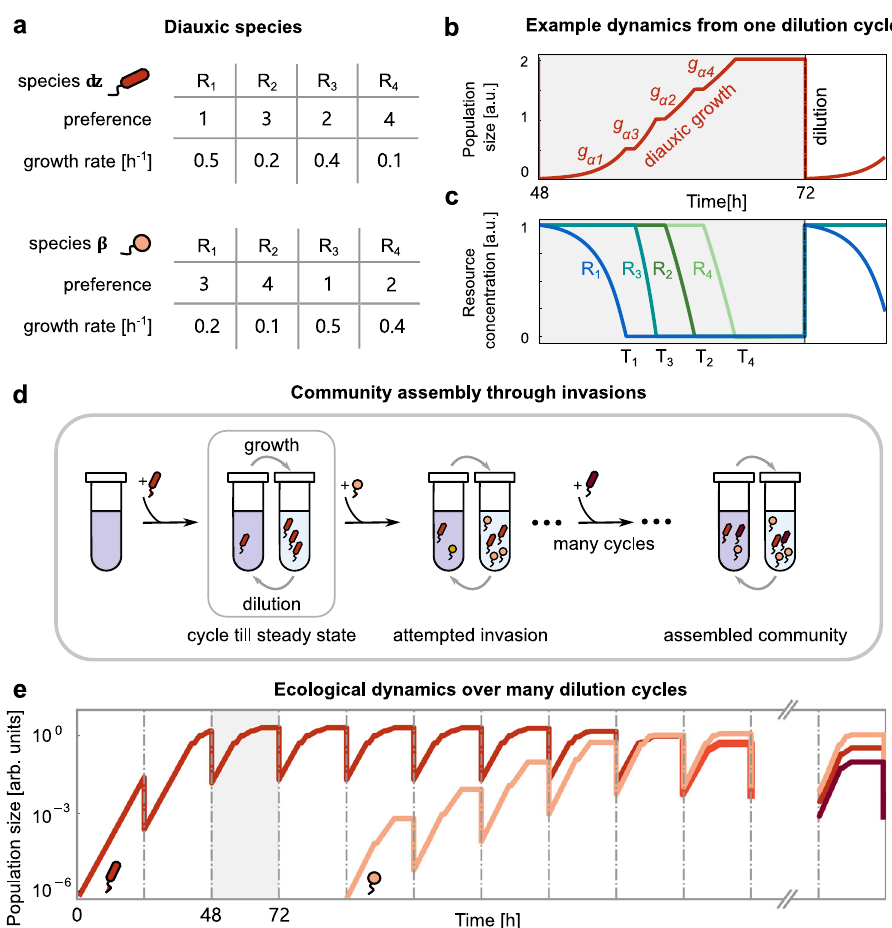
Fig. 1 Model of community assembly with diauxie and serial dilution. a Tables of growth rates and resource preferences of two species α (red) and β (yellow), each capable of consuming all four available resources, R 1 to R 4 . The resource preference sets the sequence in which a microbial species utilizes resources, and the corresponding rates g Xi indicate the growth rate while consuming each resource (see “ Methods ” ). b Diauxic growth curve of species α during one serial dilution cycle, which has 4 phases of growth on each individual resource, with rates g α 1 , g α 3 , g α 2 , and g α 4 , respectively (with a brief lag period between two phases). At the end of each dilution cycle, we dilute the population by a factor D = 100, and supply fresh resources (see “ Methods ” ). c Resource depletion curves corresponding to ( b ), where each resource is represented by a different color. R 1 is exhausted at time T 1 ; then species α consumes R 3 which runs out at T 3 , which is followed by exhaustion of R 2 at T 2 , and so on. d Schematic of serial dilution experiment. During community assembly, new species are added one by one from a species pool. After each successful invasion, the system undergoes several growth-dilution cycles until it reaches a steady state. e Population dynamics corresponding to the assembly process in ( d ). Panels ( b ) and ( c ) correspond to a small section of this process (highlighted in gray), where the community dynamics consist only of species α (red) reaching a steady